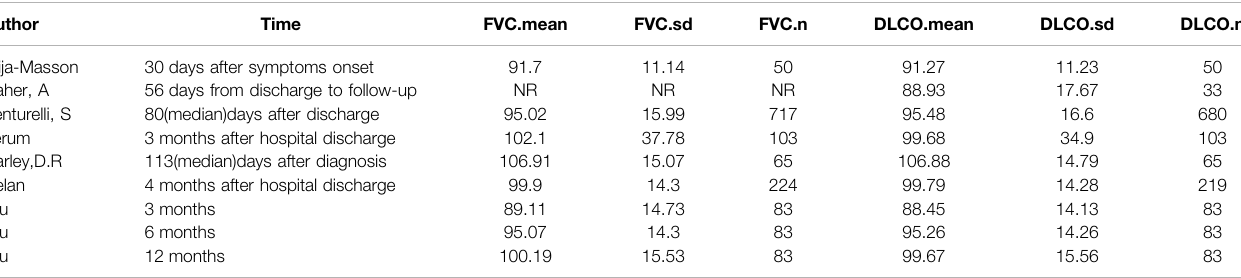
TABLE 3 | Summary of re-calculations of median into mean using R